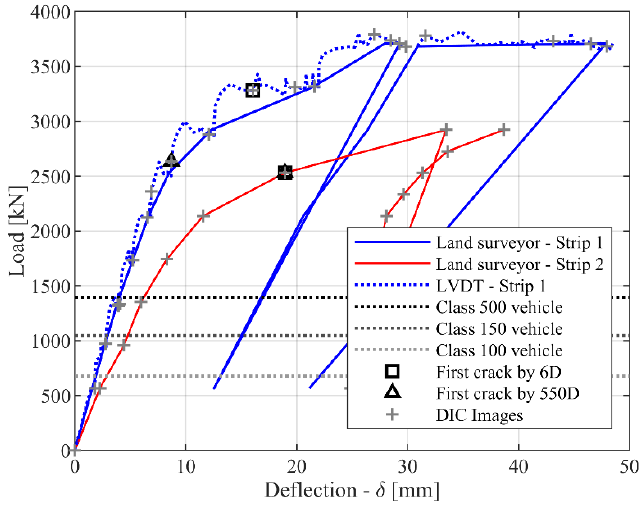
Figure 14. Load/deflection curve—strip tests.